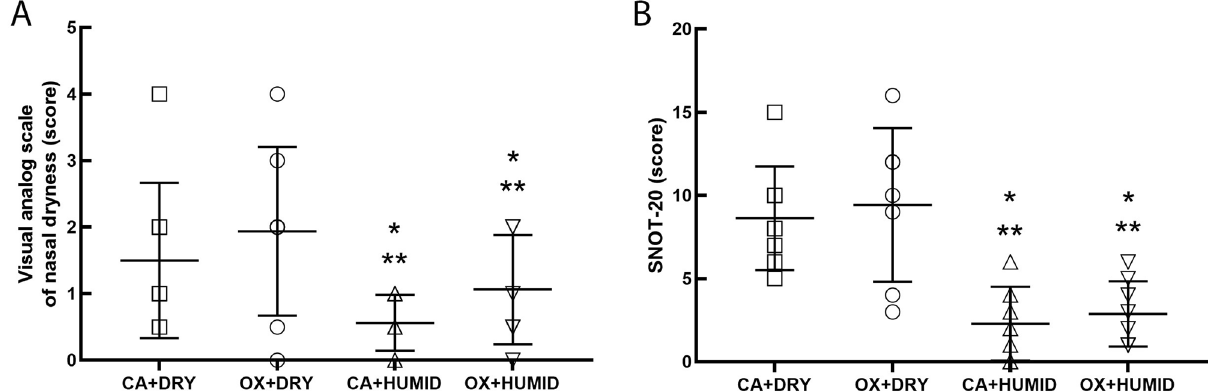
Figure 3. Visual analog scale of nasal dryness ( A ) and SNOT-20 ( B ). *P < 0.05 compared to CA + DRY group. **P < 0.05 compared to OX + DRY